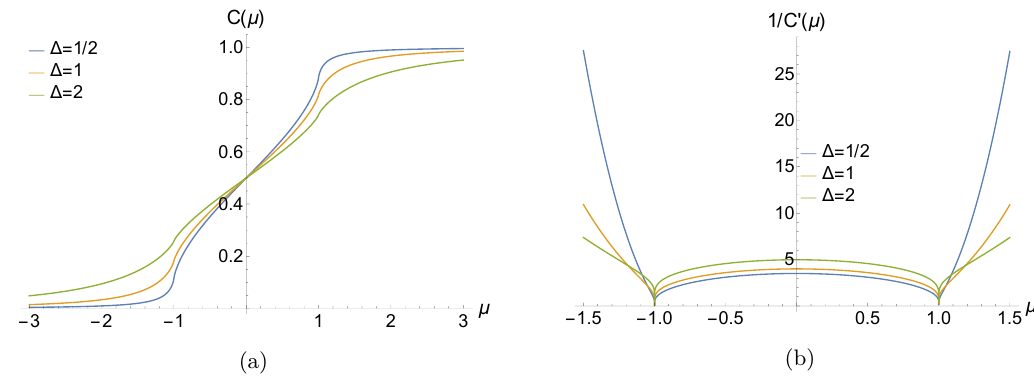
Figure 6 . a) The spread complexity for the circuit connecting the vacuum and the Kitaev chain ground state in the continuum limit. We have set J = 1 . The spread complexity is monotonically increasing as a function of µ . b) The inverse of the derivative of the spread complexity as a function of µ for ∆ = 1 and J = 1 . At the phase transition the derivative diverges so that its inverse 2 approaches